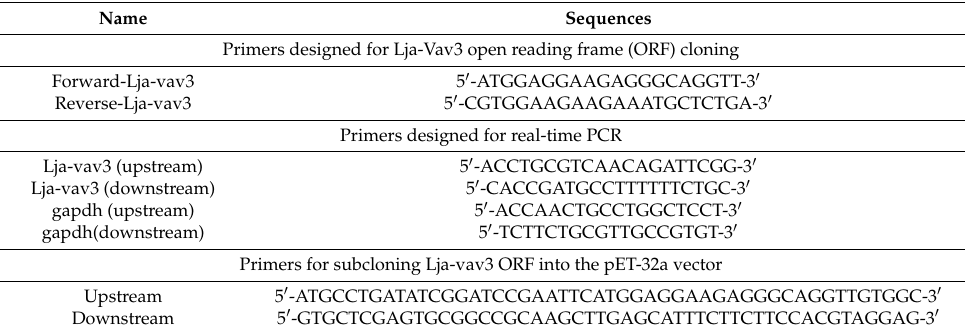
Table A1. The sequences of primers used in this